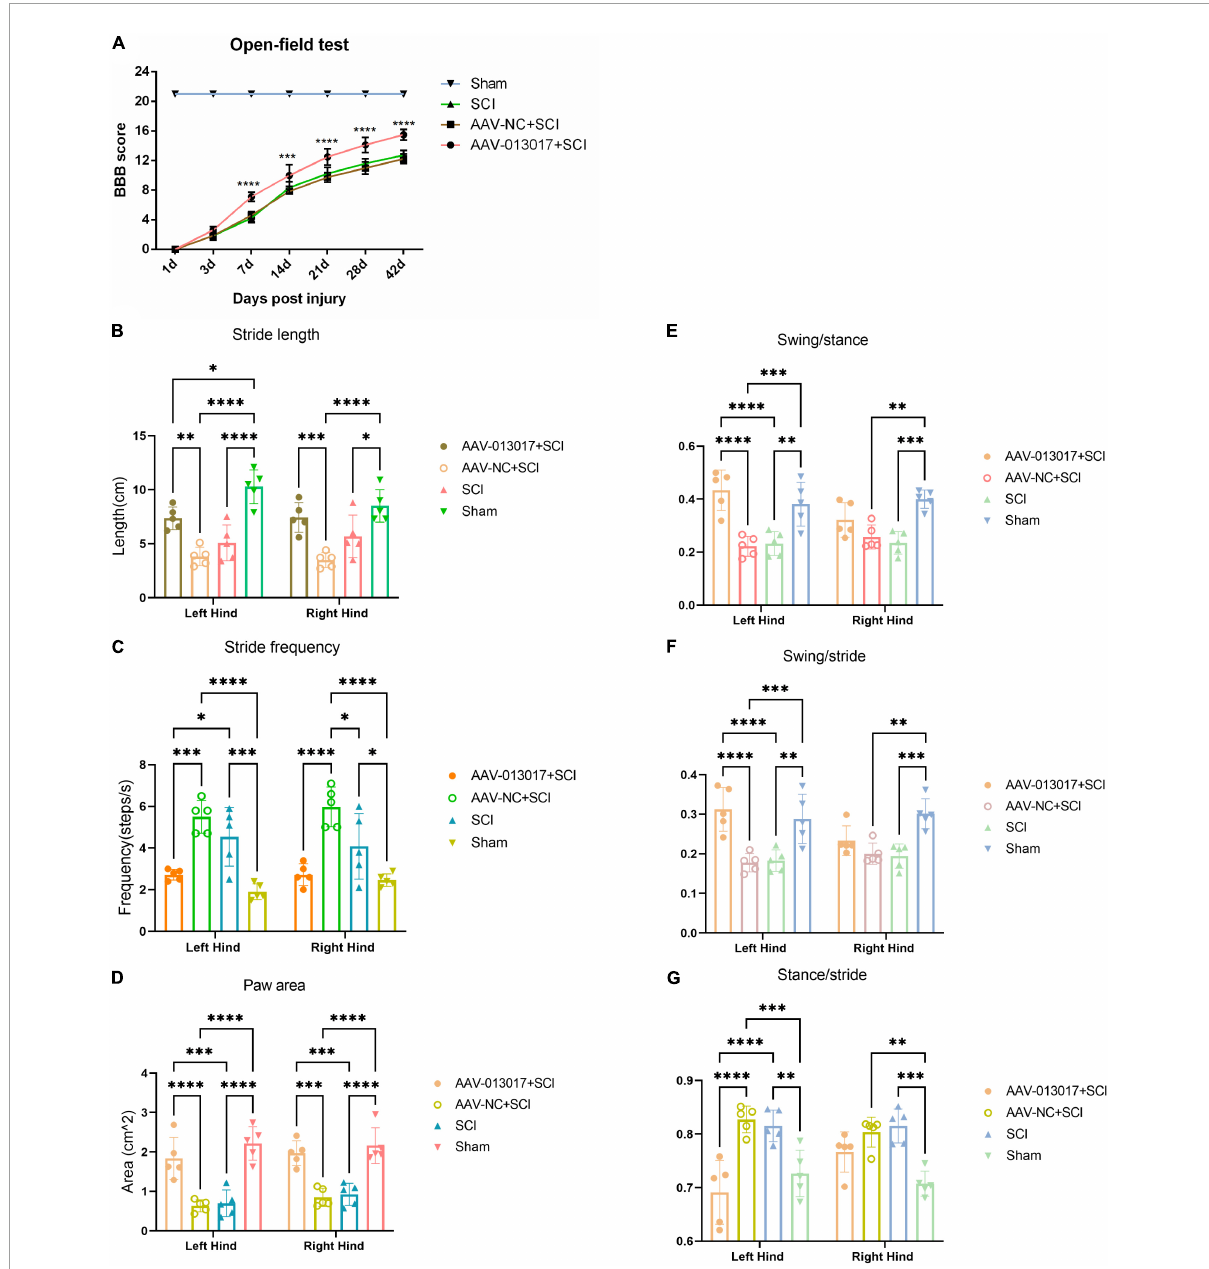
FIGURE7 Improvement by rno-circRNA-013017 of the locomotor function of rats after SCI. (A) BBB scores among different groups were evaluated by an open field test ( n = 5 per group). ∗∗∗ Indicates p < 0.001 for the AAV-013017 + SCI group vs. AAV-NC + SCI group; ∗∗∗∗ indicates p < 0.0001 for the AAV-013017 + SCI group vs. AAV-NC + SCI group; (B–G) Gait analysis using an automated treadmill with relative indexes: Stride length, stride frequency, paw area, swing/stance, swing/stride, and stance/stride. ∗ Indicates p < 0.05, ∗∗ indicates p < 0.01, and ∗∗∗ indicates p < 0.001, ∗∗∗∗ indicates p < 0.0001. Data are shown as means ±